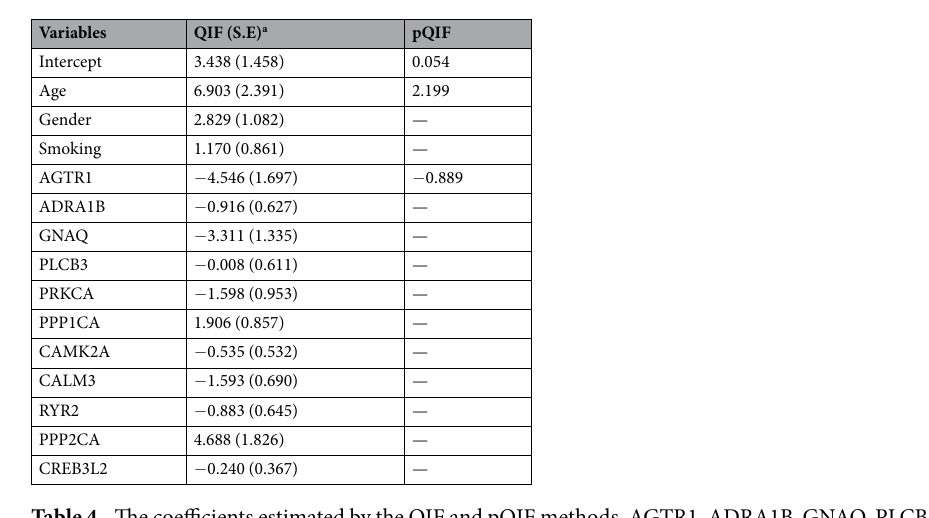
on antihypertensive medications being taken at the time of diagnosis. A description of the related phenotype data is summarized in Table 3. The adrenergic signaling pathway has been related to hypertension and studies have shown that large genetic variations exist in the genes involved in this pathway 40–42 . Thus, we focused our analysis on this pathway and evaluated the relationship between the involved genes and hypertension. Adrenergic signaling in cardiomyo- cytes was chosen from the KEGG pathway database 43 (http://www.kegg.jp/kegg/kegg1.html). Part of the adren-